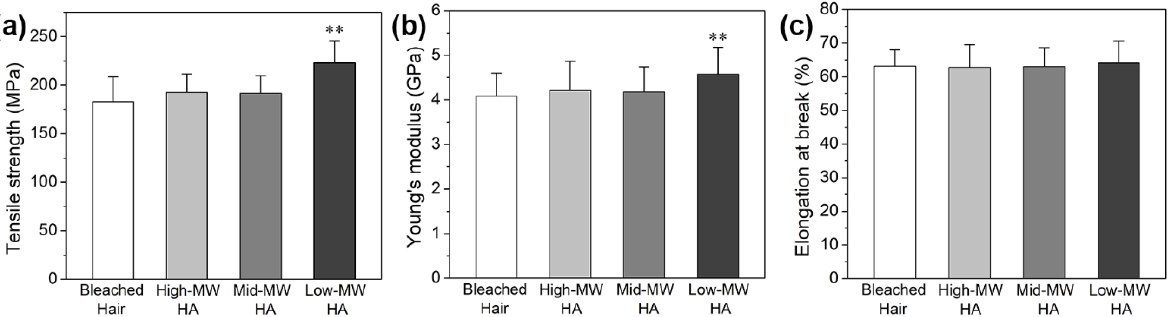
Figure 1. Effects of different MW HA treatments on tensile strength ( a ), Young’s modulus ( b ) and elongation rate ( c ) of bleached hair. (Significance: ** p < 0.01 vs. bleached hair. N = 30).